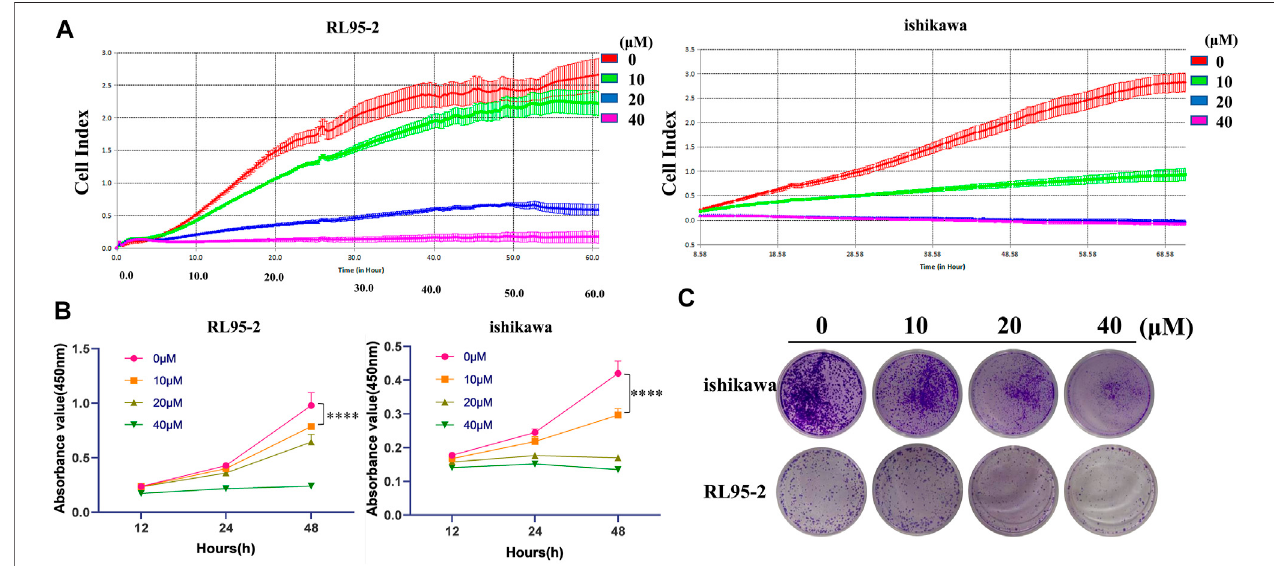
FIGURE 5 | Icarisid Ⅱ displayed cytotoxic effect against human endometrial cancer cells. (A) Grow curves of cancer cells RL 95-2 and ishikawa in the presence of Icarisid Ⅱ . (B) CellviabilityofRL95-2andishikawainthepresenceofIcarisid Ⅱ at12,24,and48 h. (C) InhibitoryeffectofIcarisid Ⅱ againstcellcolonyformationofRL95-2 and